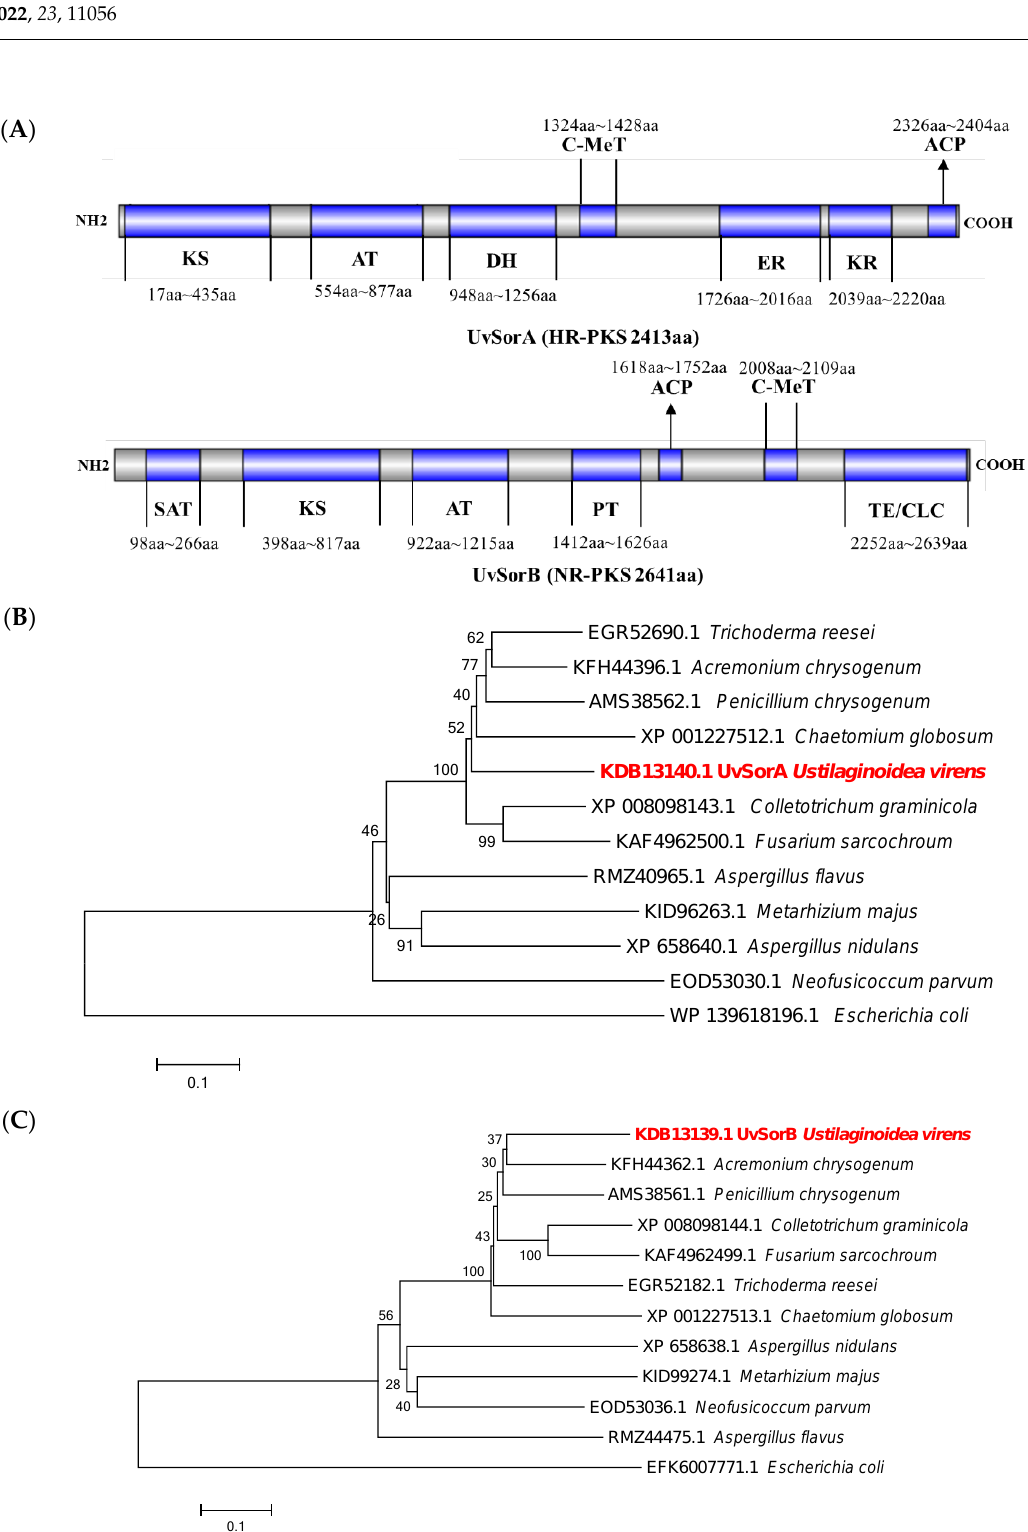
Figure 2. Identification and characterization of UvSorA and UvSorB. ( A ) Schematic diagram of UvSorA and UvSorB functional domains analysis. ACP, acyl carrier protein; AT, acyl transferase; C-MeT, C-methyltransferase; DH, dehydratase; ER, enoylreductase; KR, β -ketoacyl reductase; KS, β -ketoacyl synthase; PT, product template; SAT, starter unit ACP transacylase; TE/CLC, thioesterase/Claisen cyclase. ( B ) Phylogenetic analysis of UvSorA with different orthologous. ( C ) Phylogenetic analysis of UvSorB with different orthologous. The phylogenetic tree was con- structed using the neighbor-joining (NJ) method in